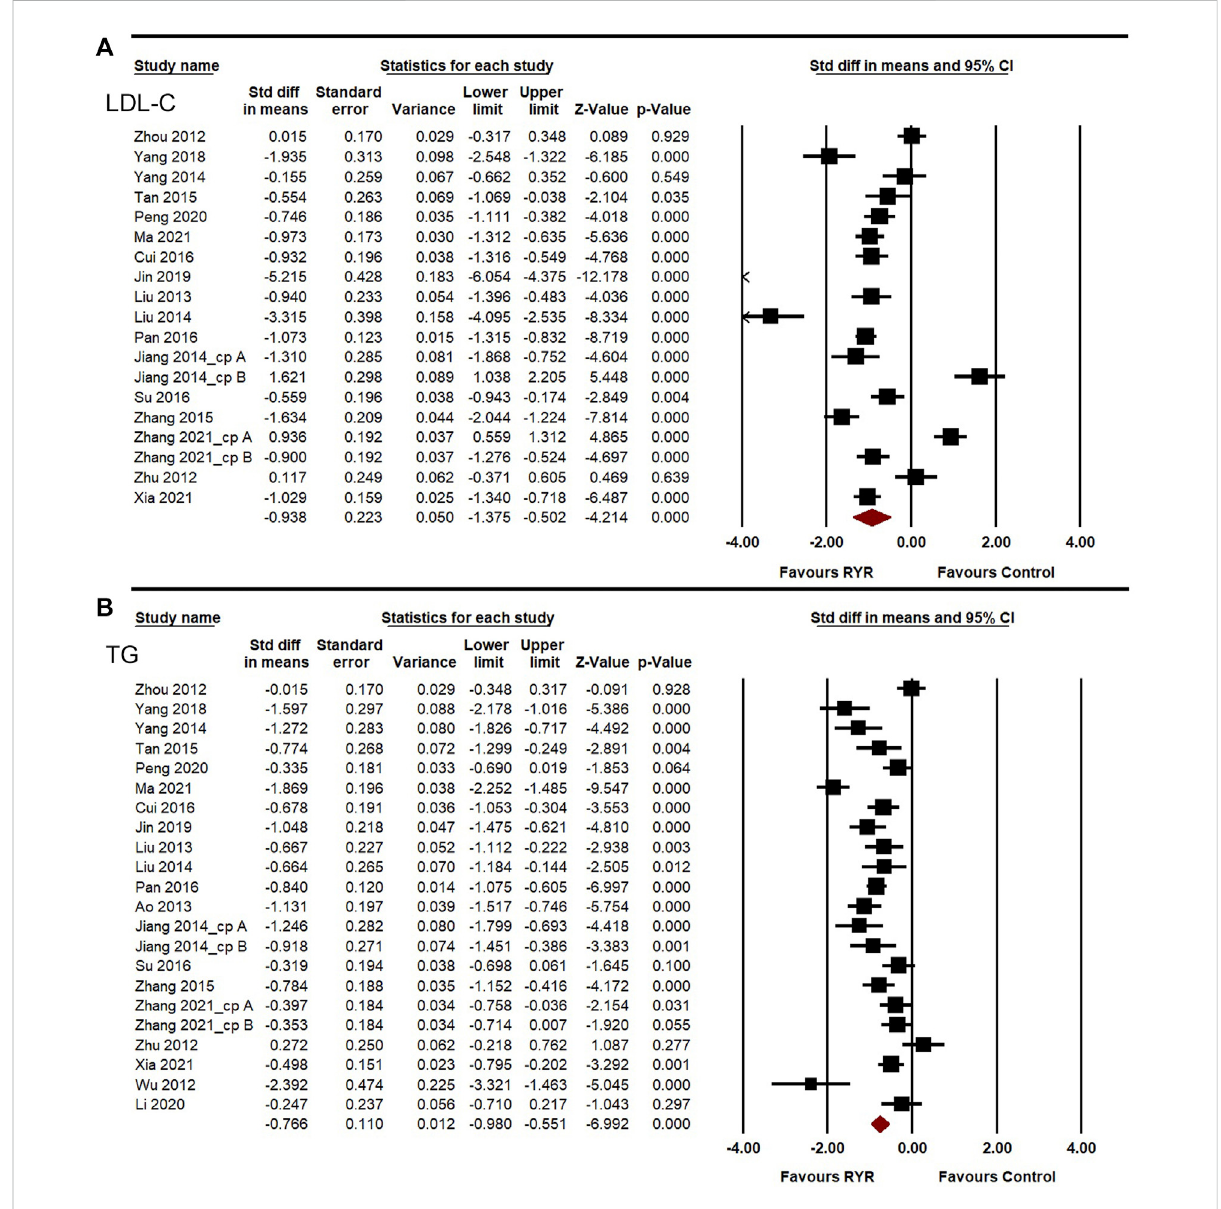
FIGURE 4 Meta-analysis of the effects of RYR therapy on LDL-C (A) and TG (B)